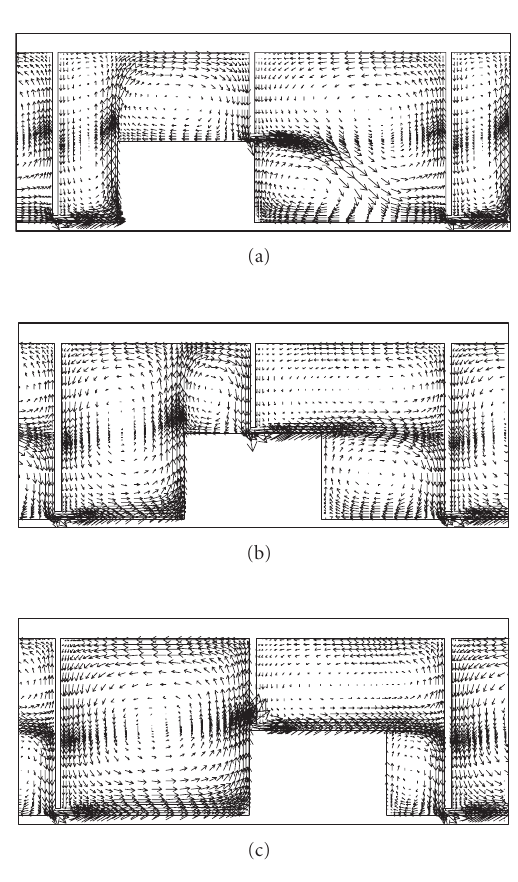
Figure 5: Flow patterns within a high-low seal for di ff erent